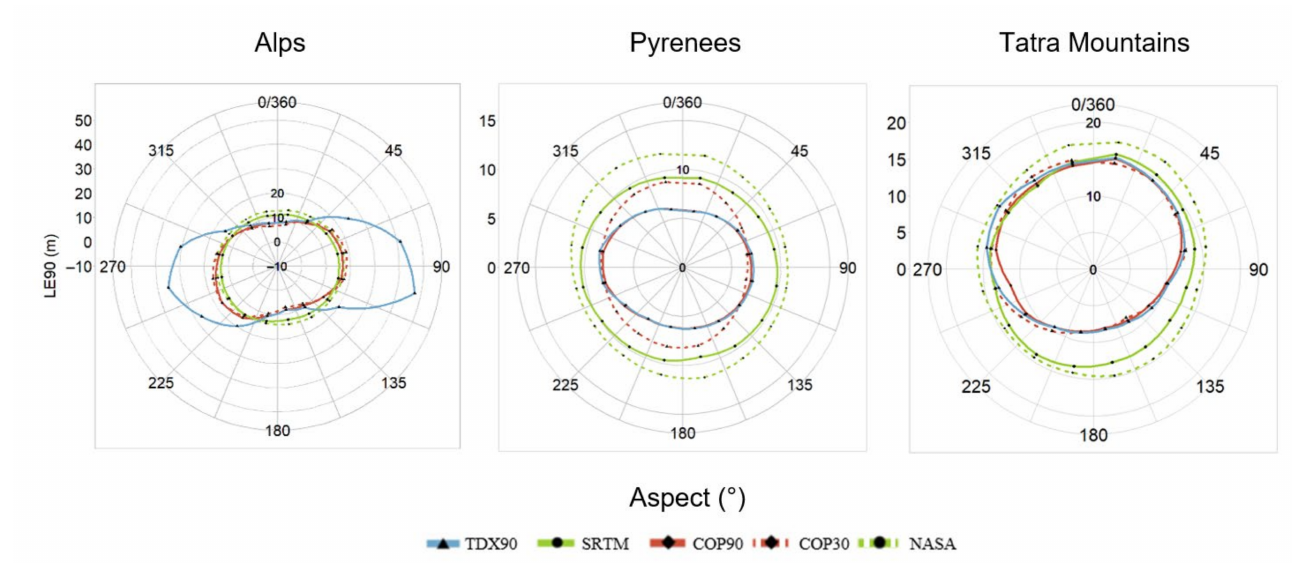
Figure 2. Absolute vertical errors of TDX90, COP90, SRTM90, COP30, and NASA30 expressed as Table 90. quantile (LE90) as a function of the terrain aspect when compared with LiDAR DSMs in the Alps ( left ), the Pyrenees ( middle ), and the Tatra mountains ( right ).